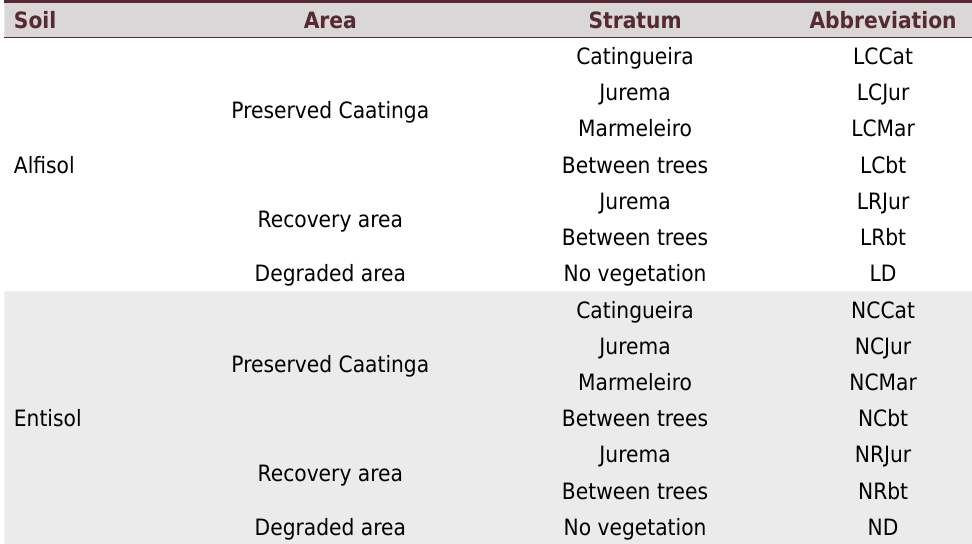
Table 1. Identification of the studied soils, areas, and strata